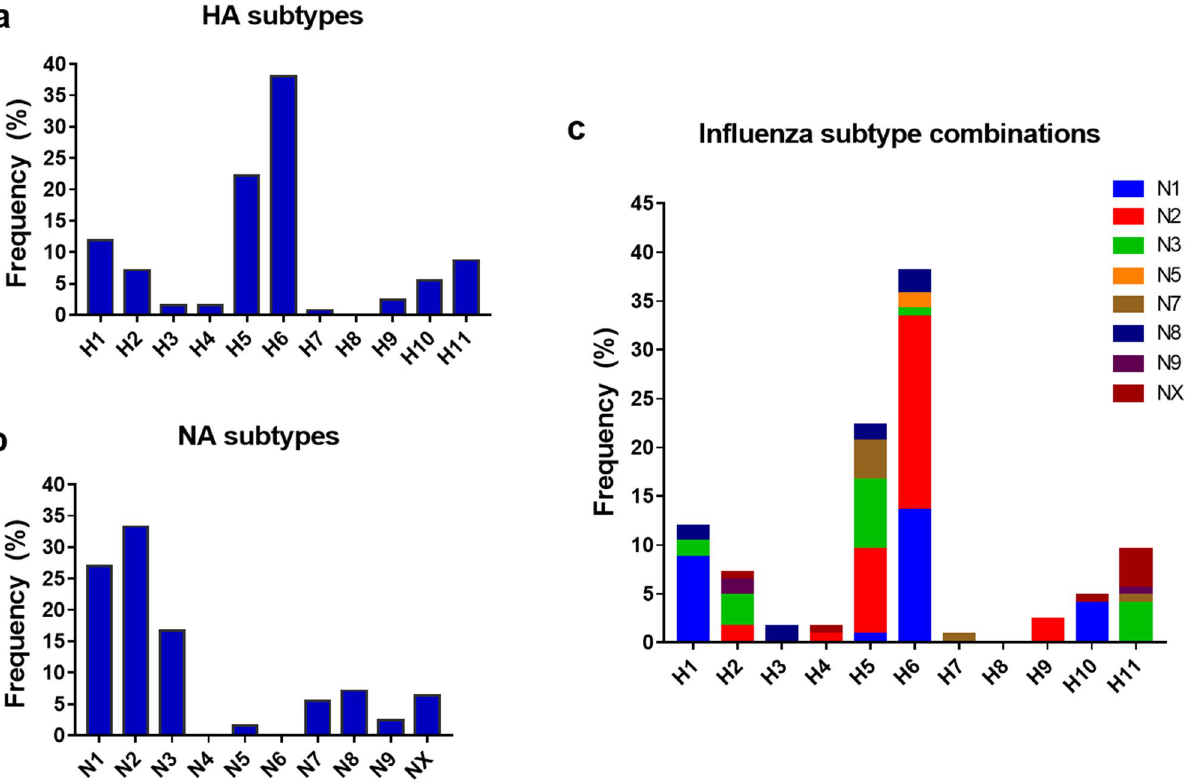
Figure 2. Overall frequency of hemagglutinin (HA) and neuraminidase (NA) subtypes of avian influenza viruses (AIVs) isolated from the fecal matter of wild migratory birds in Korea (2009–2013). The frequencies